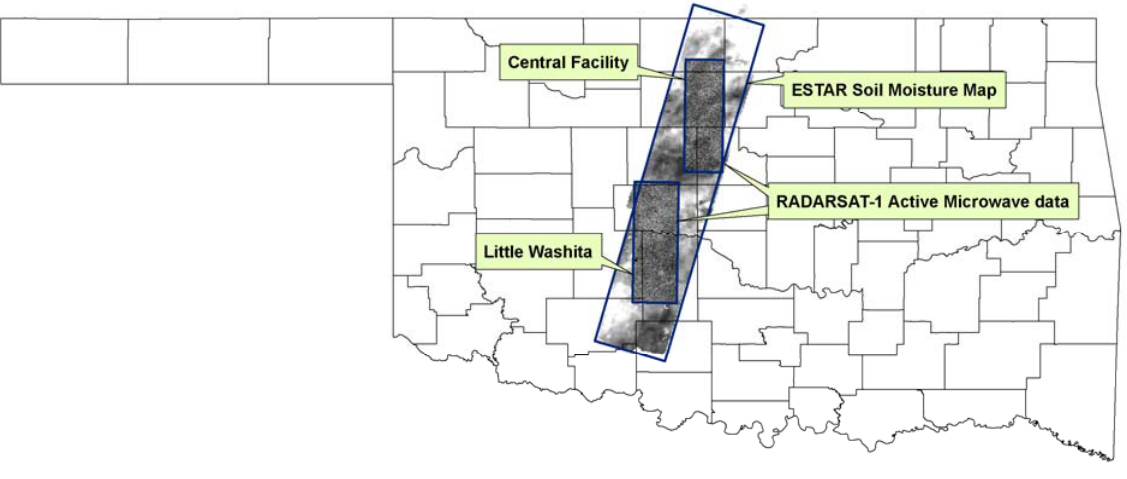
Figure 1. Two subset study Area (Central Facility and Little Washita) in Oklahoma are selected from overlapped ESTAR soil moisture product and RADARSAT-1 Active Microwave data